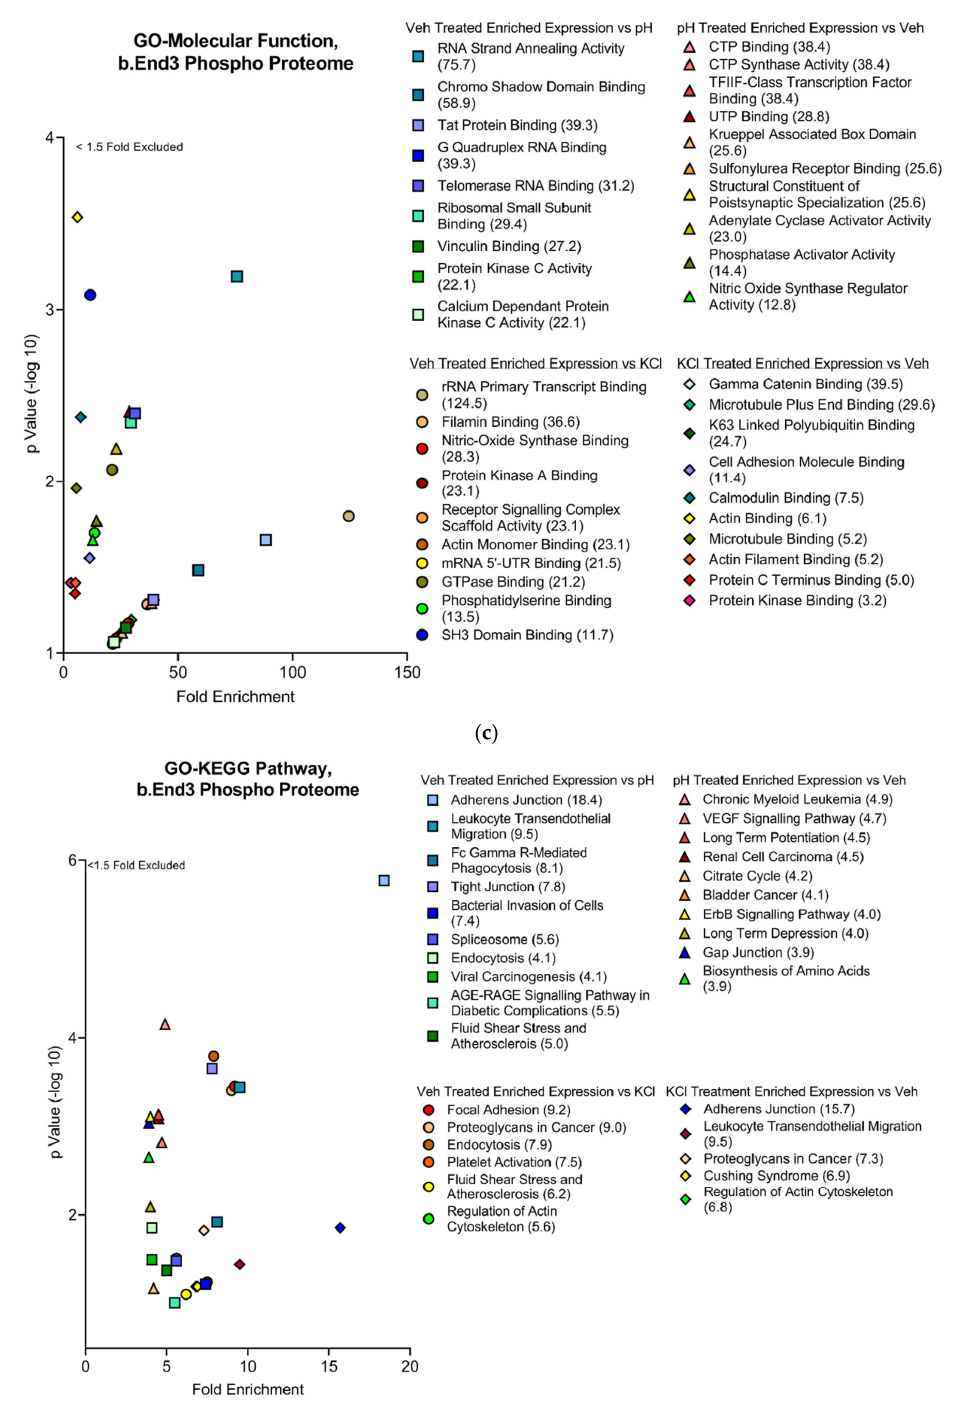
Figure 7. Global phosphorylation-enriched proteins separated by treatment group and represented by scatterplots comparing fold enrichment score (FE) against − Log10 transformed p -values. Top ten cellular processes and pathways assessed by total fold enrichment score queried through the three GO databases; ( a ) BP, ( b ) CC, ( c ) MF, and ( d ) KEGG pathway databases demonstrate highly varied upstream protein PTM modifications unique to each treatment group with convergence of effect observed in proteins associated with maintenance of structural integrity of the cell. n = 4 per treatment